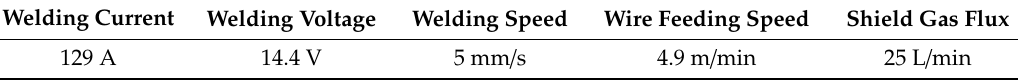
Table 2. Welding parameters.